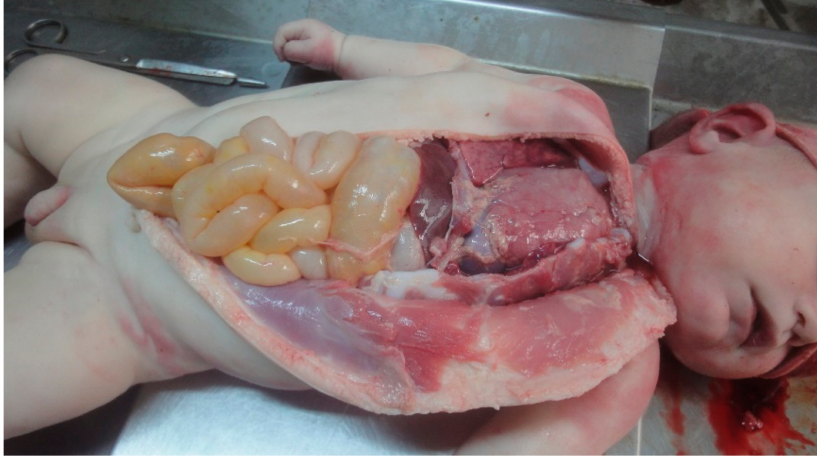
Figure 5. Autopsy aspects of case